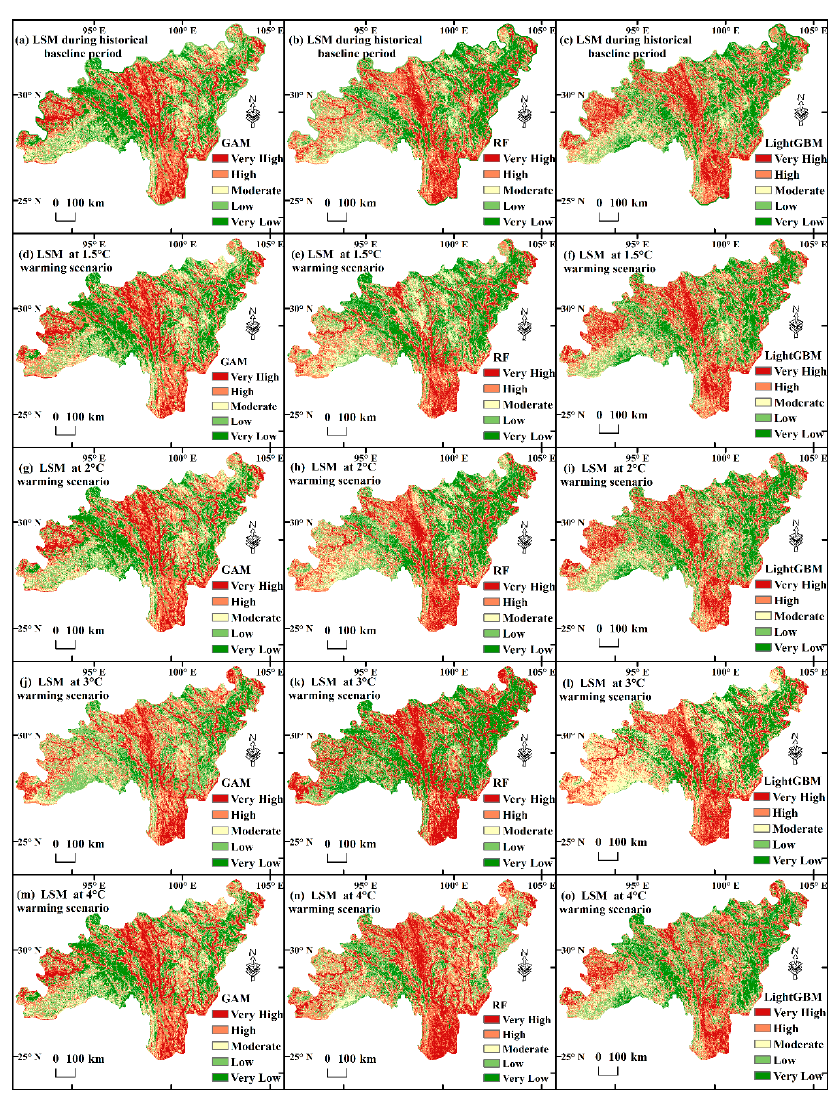
Figure 8. The spatial appearance of landslide susceptibility based on different models for historical and future scenarios: ( a , d , g , j , m ) GAM, ( b , e , h , k , n ) RF, ( c , f , i , l , o ) LightGBM.